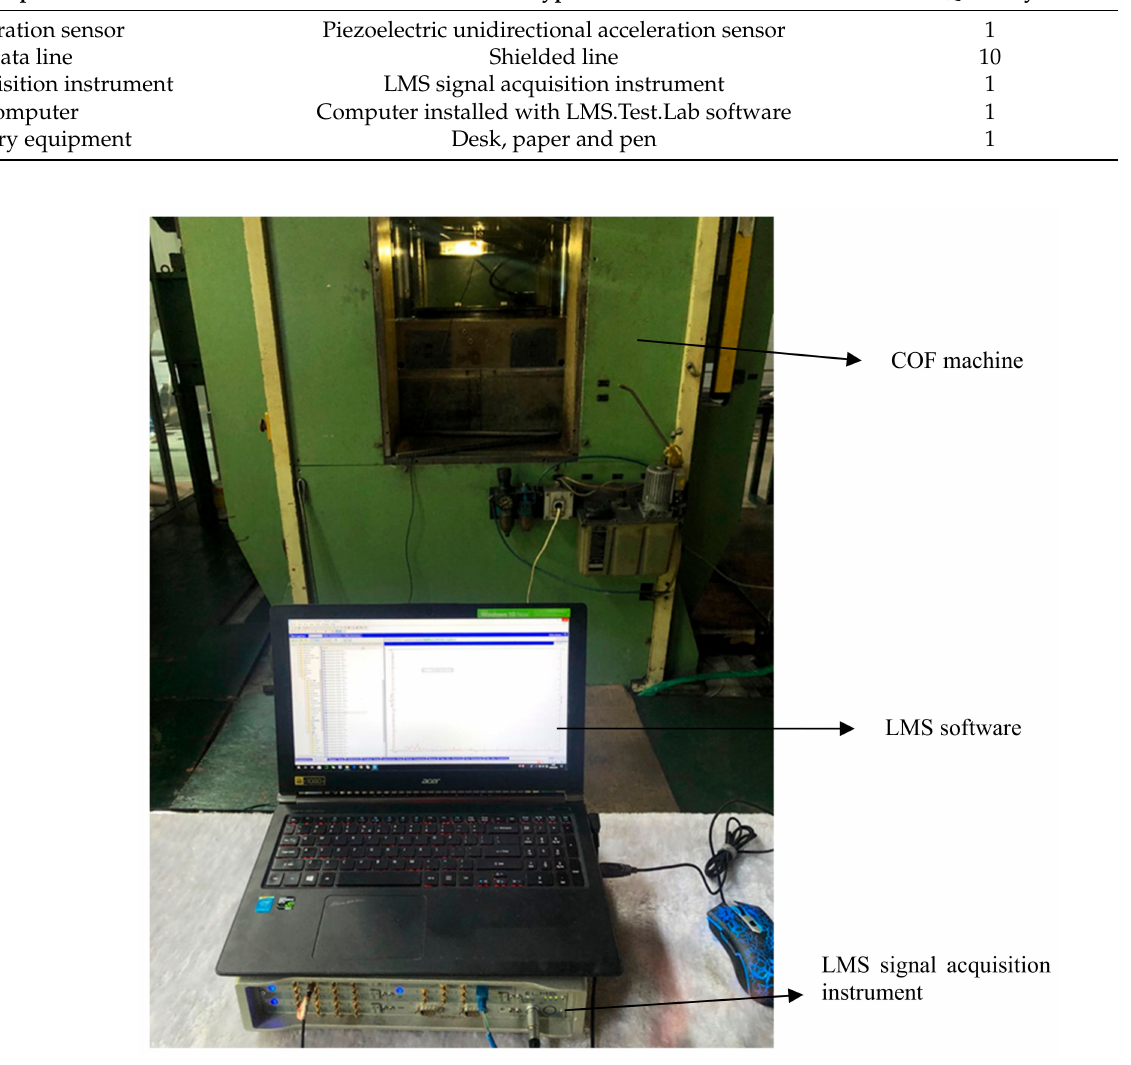
Figure 17. Verification experiment of the dynamic